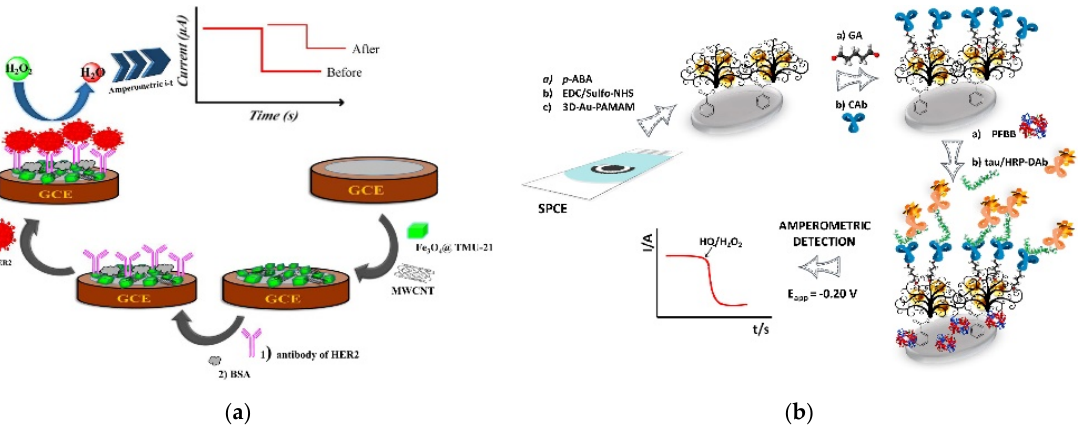
Figure 4. Examples of amperometric immunosensors with covalently immobilized antibodies. ( a ) Magnetite nanoparticles and MWCNT-based immunosensor. Antibodies were chemically immobilized with carboxylated MWCNTs through EDC/NHS chemistry. Reproduced with permission [61]. Copyright (2020) Elsevier. ( b ) AuNP-based immunosensor. Antibodies were immobilized on the amine group of the PAuNP-AMAM dendrimer nanocomposite using glutaraldehyde cross-linking. Reproduced with permission [63]. Copyright (2020) Elsevier.